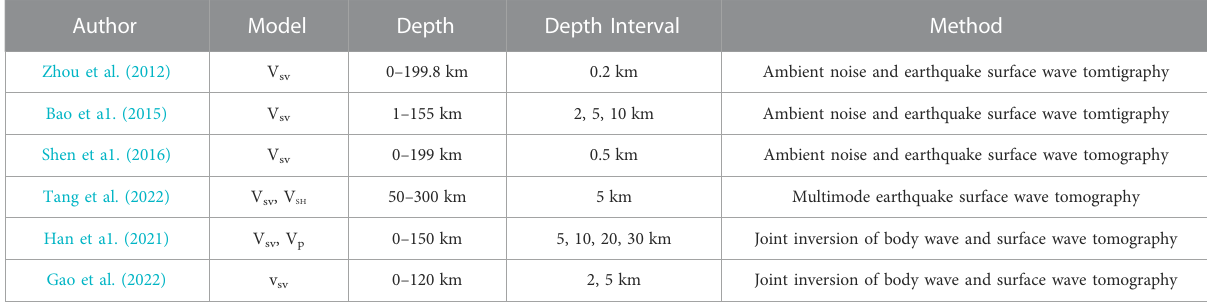
TABLE 1 Previous tomographic models used in this